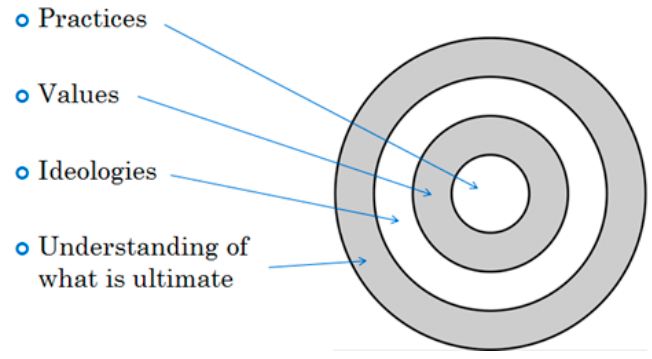
Figure 1. Schema reflecting the relationships among different classes of knowledge.